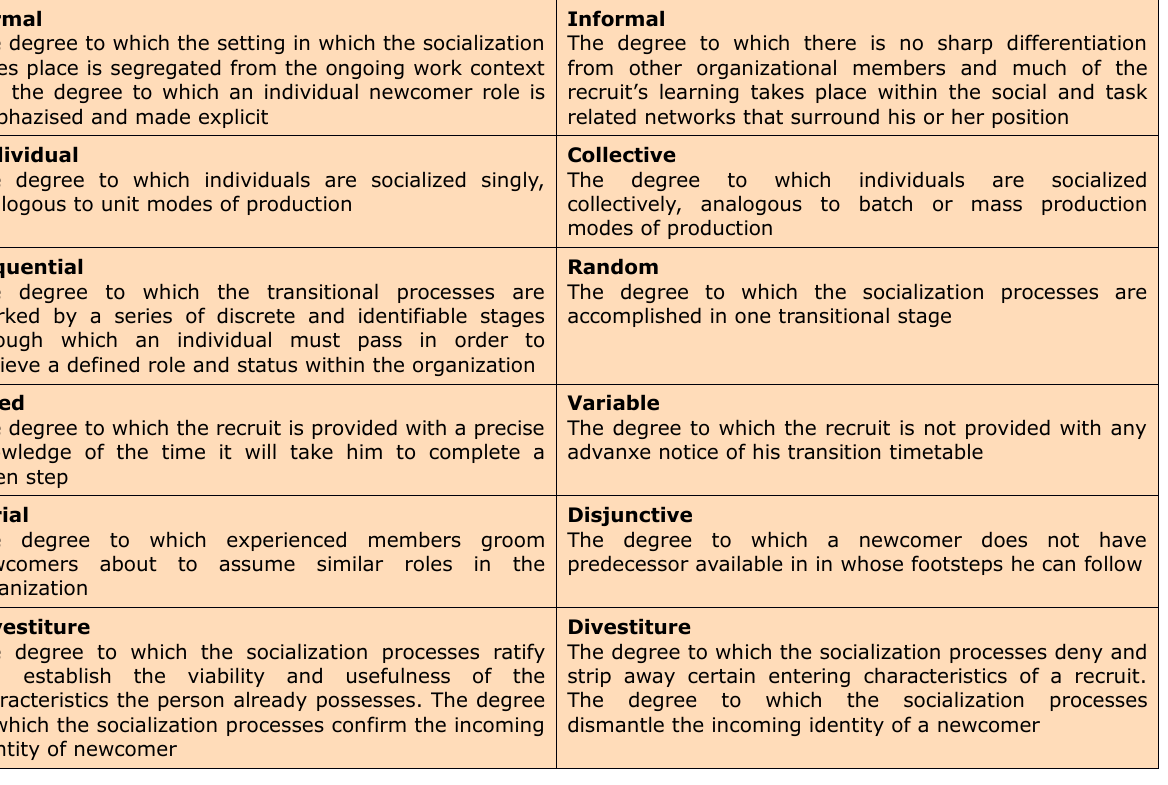
Table 2. Van Maanen’s People Processing Strategies (Baker III & Feldman,